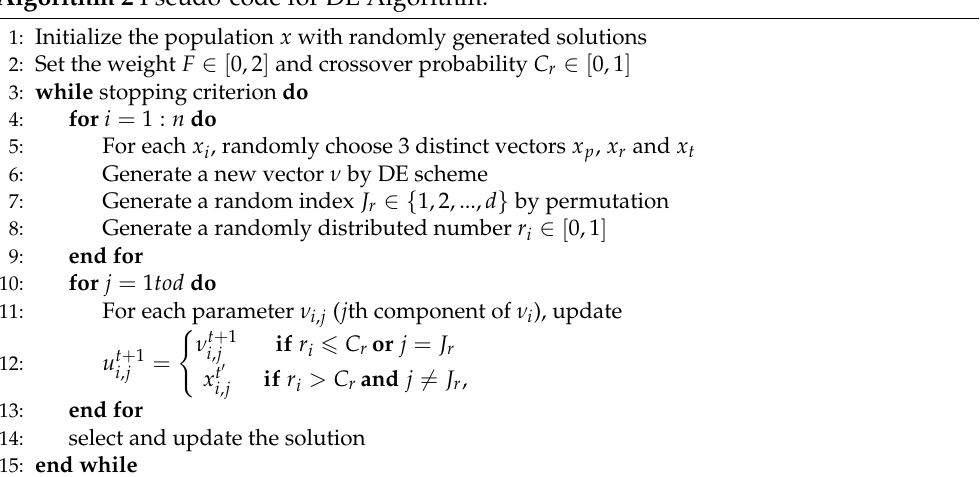
Algorithm 2 Pseudo-code for DE